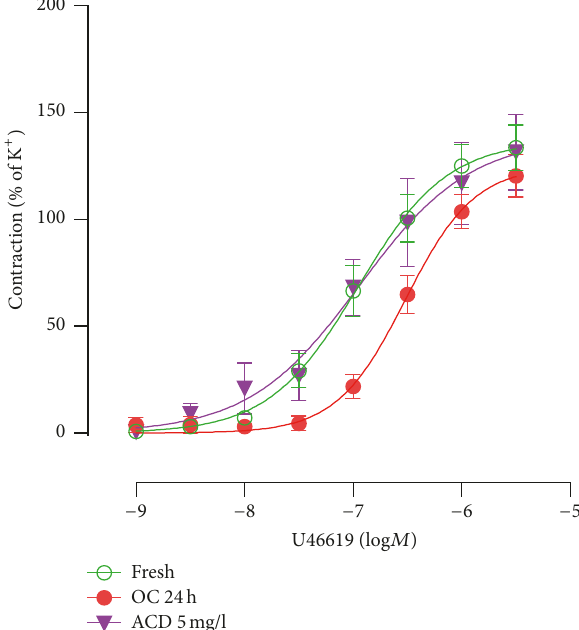
Figure 2: Effects of the transcriptional inhibitor actinomycin D (ACD 5mg/L) on U46619-induced contraction. The artery segments were organ cultured in the presence of vehicle or ACD (5 mg/L) for 24 h. Fresh = noncultured segments. Data are shown as means ± SEM. Each data point is derived from 4–8